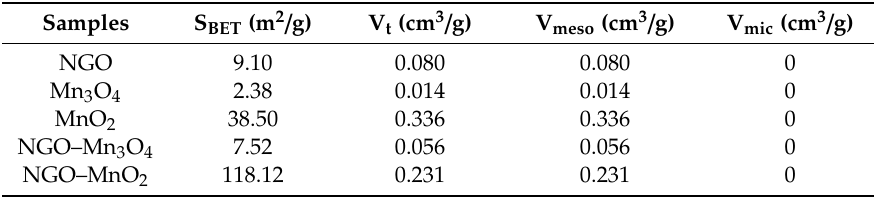
Textural parameters of the manganese oxides, of NGO and of NGO–Mn 3 O 4 and NGO–MnO 2